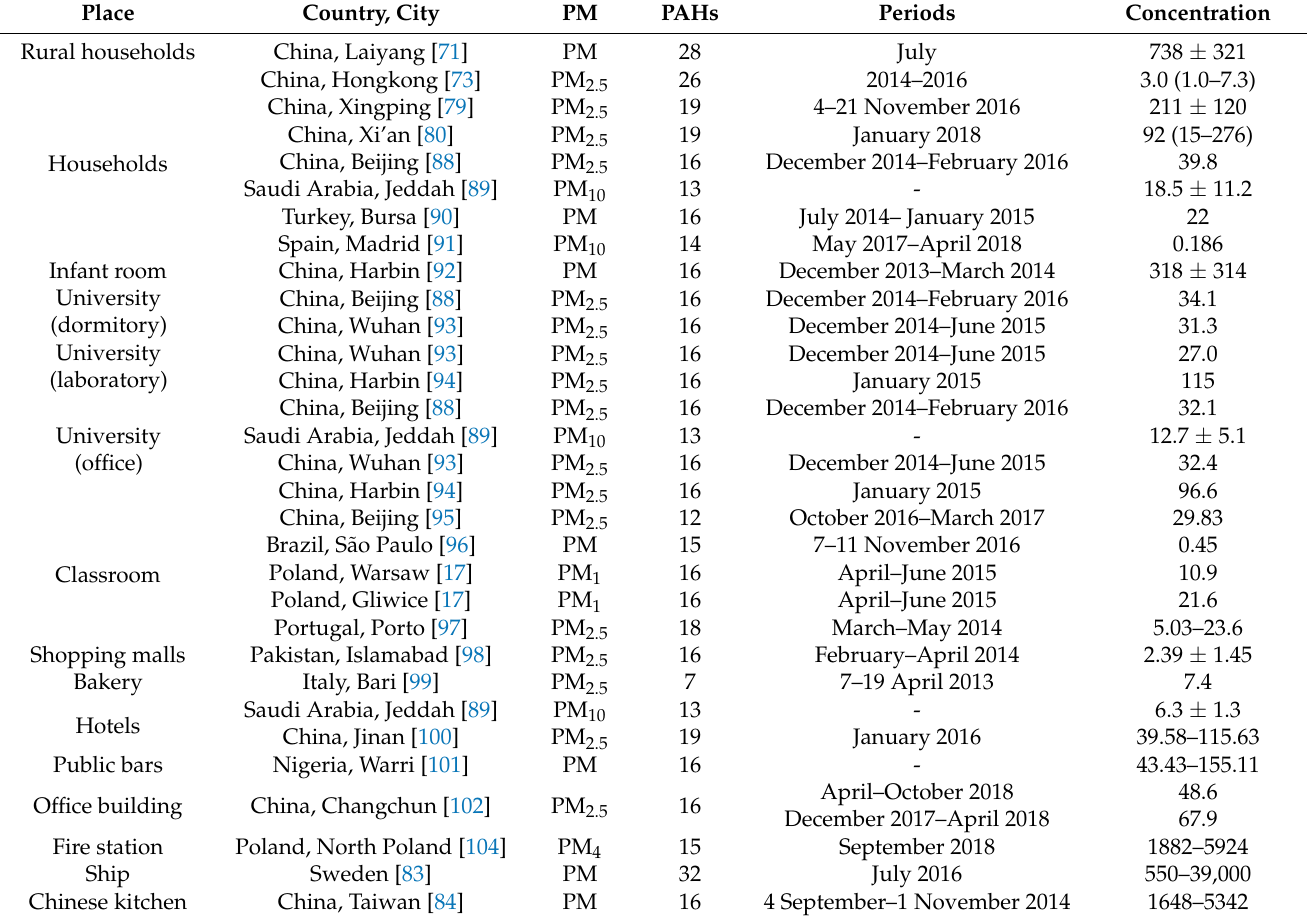
Table 5. Indoor concentrations (average and/or range, ng/m 3 ) of PM-bound PAHs in several studies. Place Country, City PM PAHs Periods